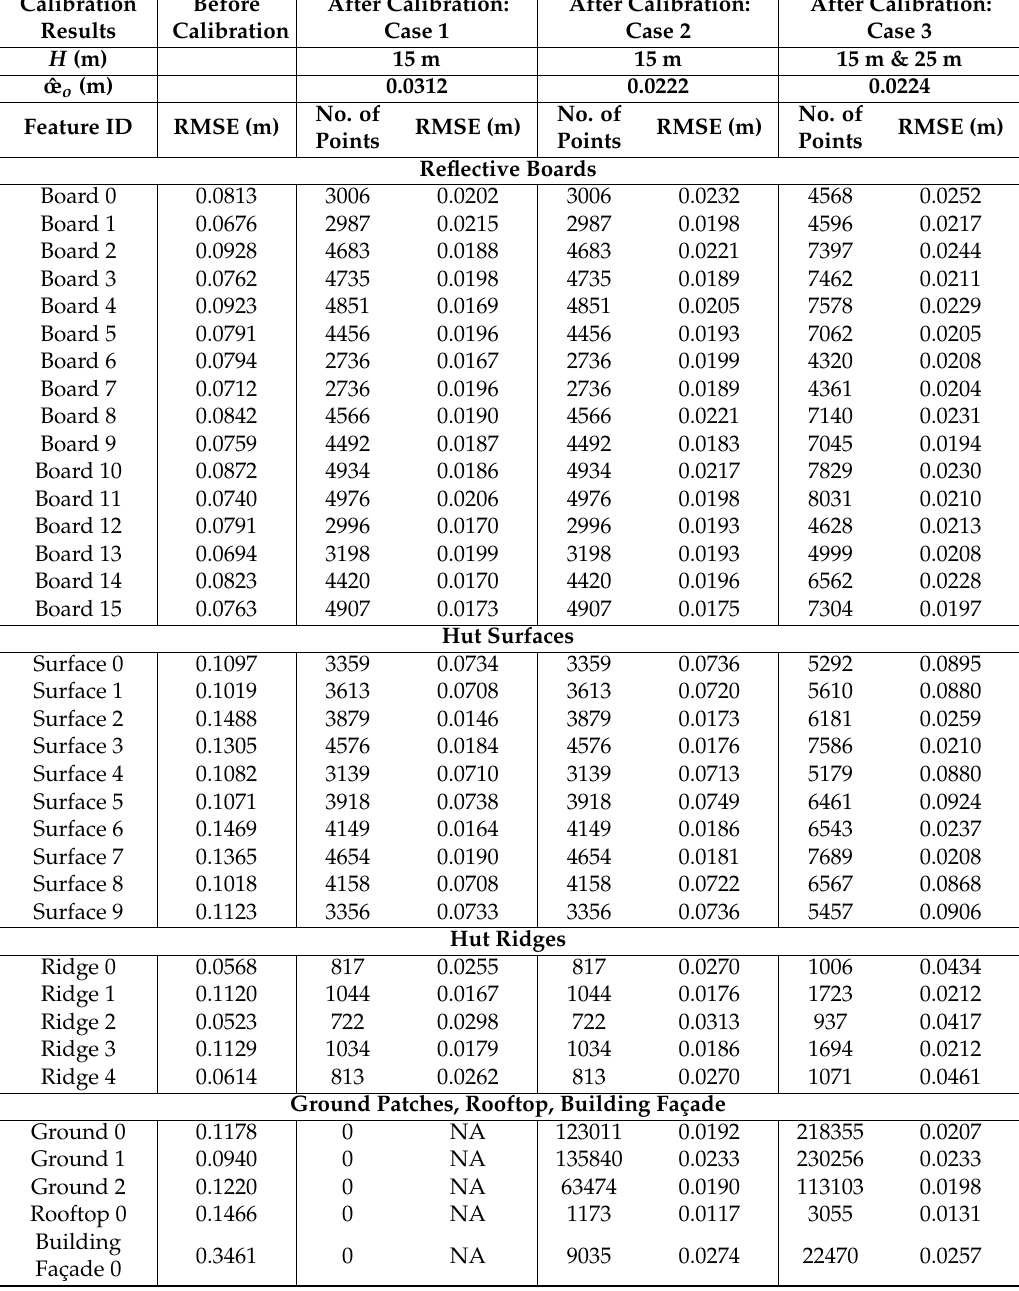
Table 8. Calibration of the UAV system: Square root of the a-posteriori variance factor (ˆ σ o ) and RMSE of plane/line fitting for different